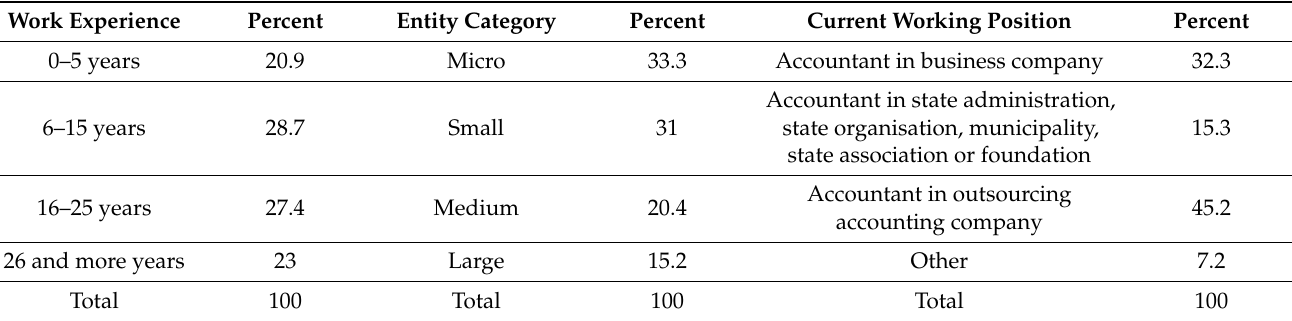
Table 2. Distribution of Respondents by